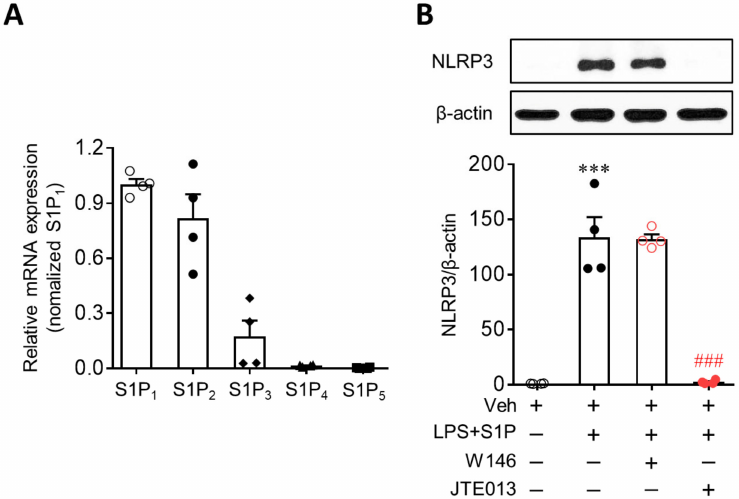
Figure 2. JTE013, an S1P 2 antagonist, attenuates S1P-enhanced NLRP3 upregulation in LPS-primed BMDMs. ( A ) Expression of S1P receptors at mRNA levels was determined in BMDMs using qRT- PCR analysis. n = 4 per group. ( B ) Effects of W146 (an S1P 1 antagonist, 1 µ M) or JTE013 (an S1P 2 antagonist, 10 µ M) on NLRP3 expression were analyzed by Western blot. Cells were pretreated with W146 or JTE013 for 30 min. Cells were then primed with LPS (500 ng/mL) for 4 h and exposed to S1P (1 µ M) for 1 h. n = 4 per group. *** p < 0.001 versus control BMDMs (Veh). ### p < 0.001 versus LPS/S1P-treated BMDMs (LPS + S1P).